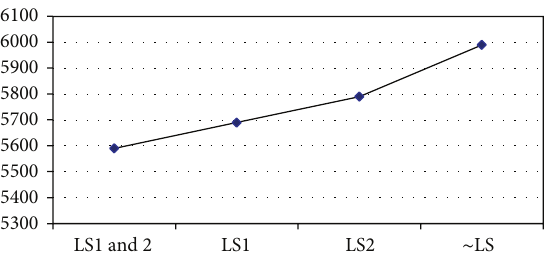
Figure 3: The effect of local searches on quality of GA.